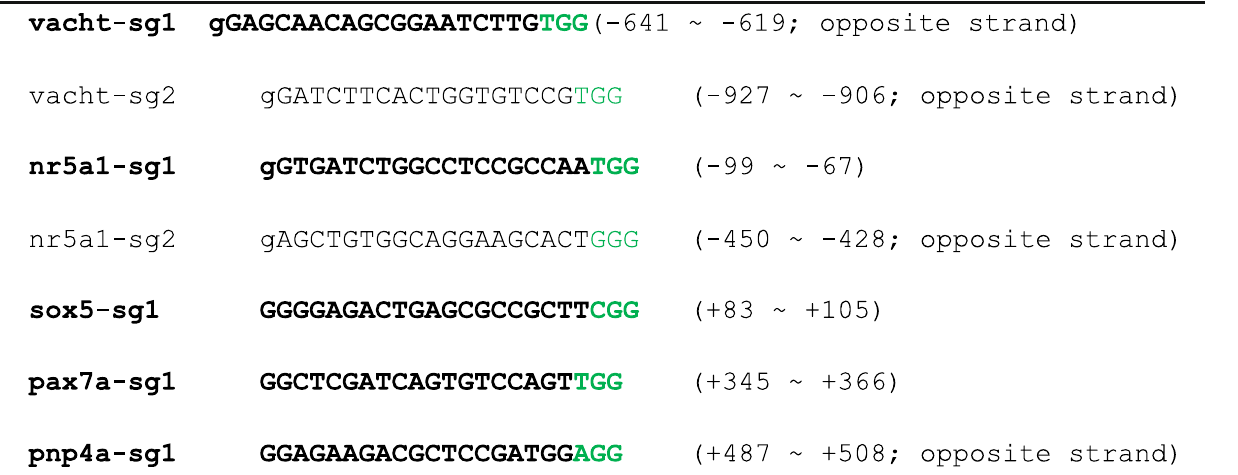
Table 1 DNA sequences for the corresponding sgRNAs